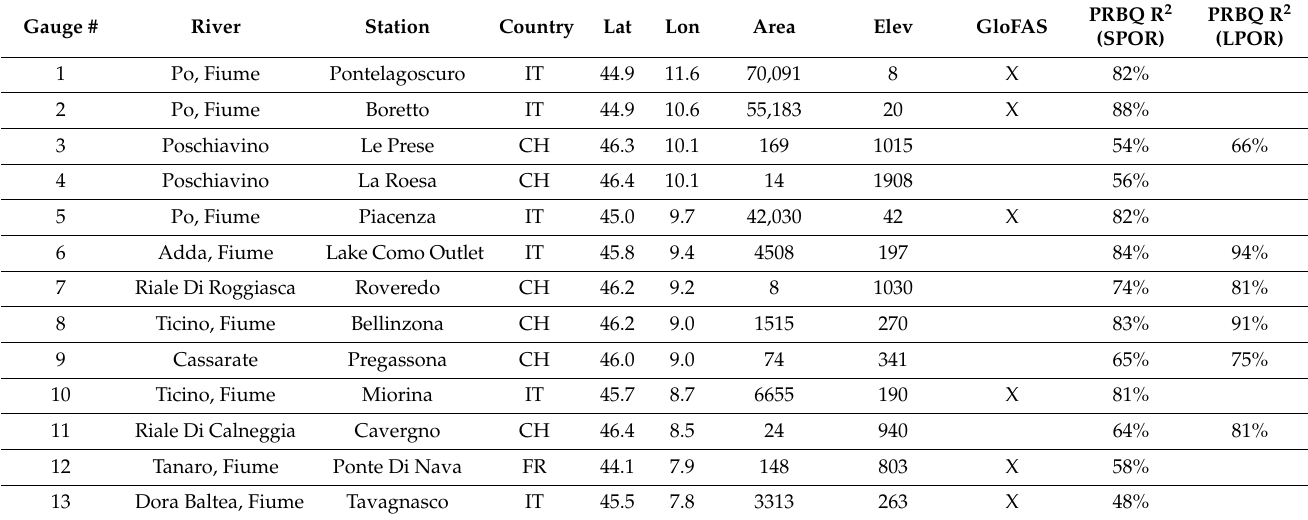
Table 1. Streamflow gauge information (gauge #, river, station name, country, latitude ( o ), longitude ( o ), area (square kilometers), elevation (meters), GloFAS data supplemented, PRBQ SPOR R 2 , and PRBQ LPOR R 2